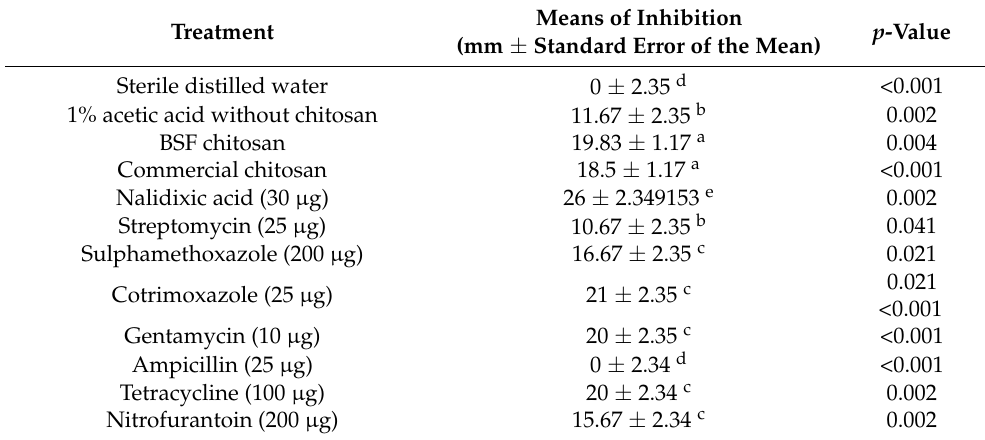
Table 2. Antimicrobial effects of BSF, commercial chitosan, and antibiotic discs against R. solanacearum .